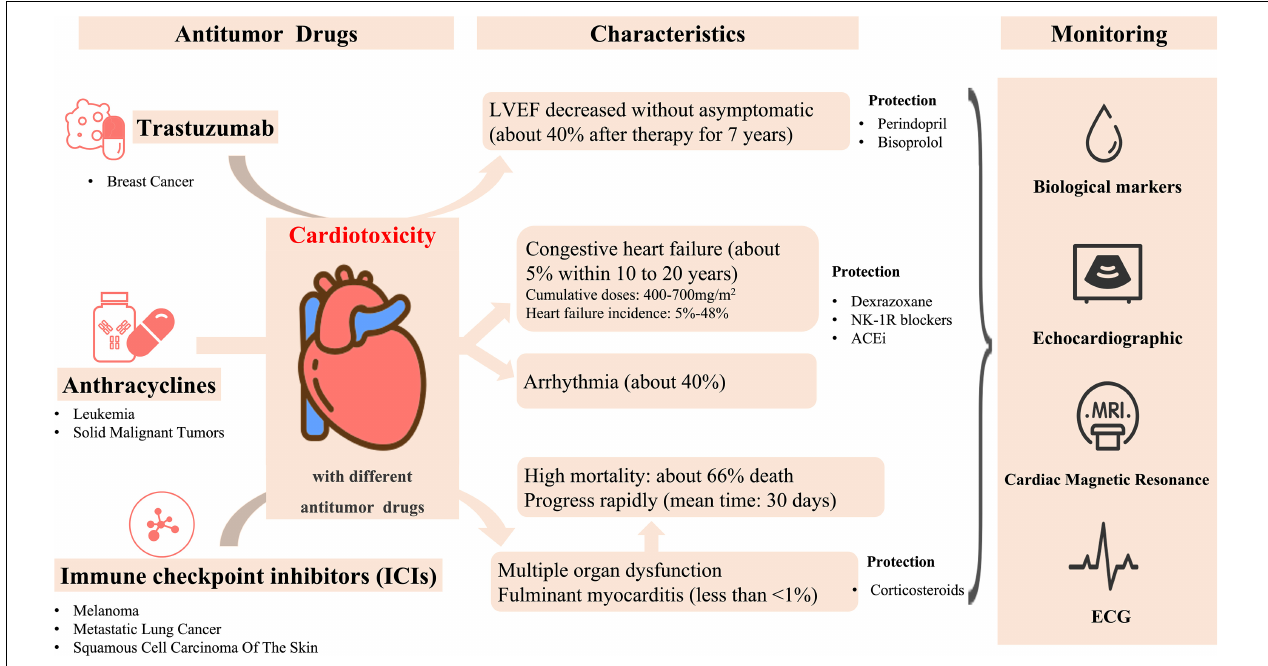
FIGURE 1 | Some antitumor drugs and their characteristics of